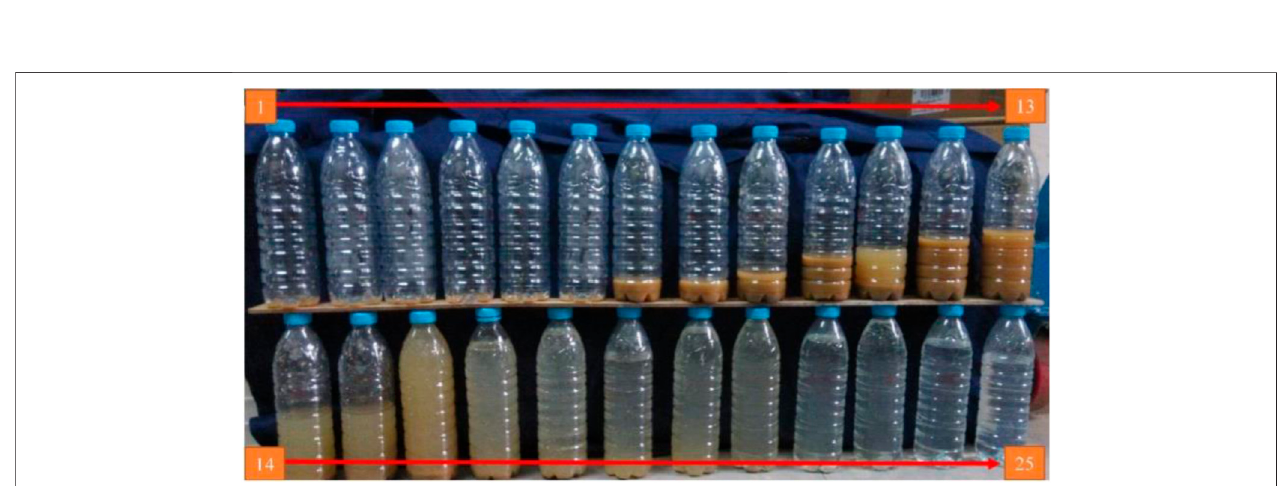
FIGURE 9 | Evolution picture of water and sand gushing ( n (cid:1)